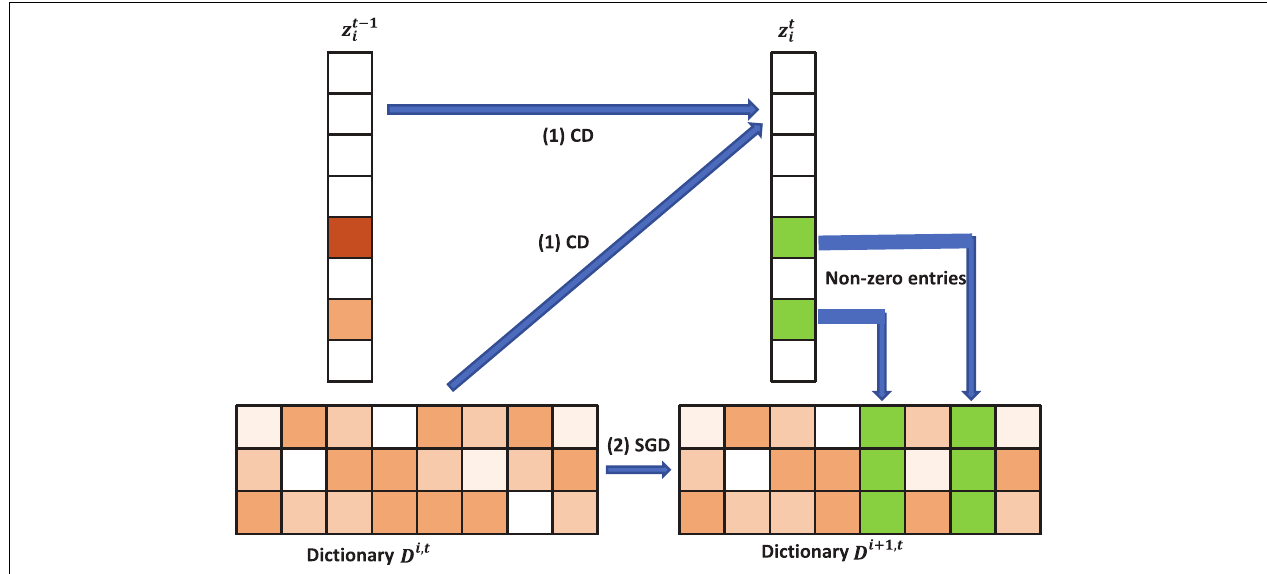
FIGURE 2 | Illustration of one iteration of the proposed Patch Analysis-based Surface Correntropy-induced Sparse-coding (PASCS) algorithm. The input is many 10 × 10 patches on each surface based on our multivariate morphometry statistics (MMS). With an image patch x i , PASCS performs one step of coordinate descent (CD) to find the support and the sparse code. Meanwhile, PASCS performs a few steps of CD on supports (non-zero entries) to obtain a new sparse code z k i . Then, PASCS updates the supports ( green boxes in the figure ) of the dictionary by stochastic gradient descent (SGD) to obtain a new dictionary D i 1 , t . Here , t represents the t- th epoch; i represents the i -th